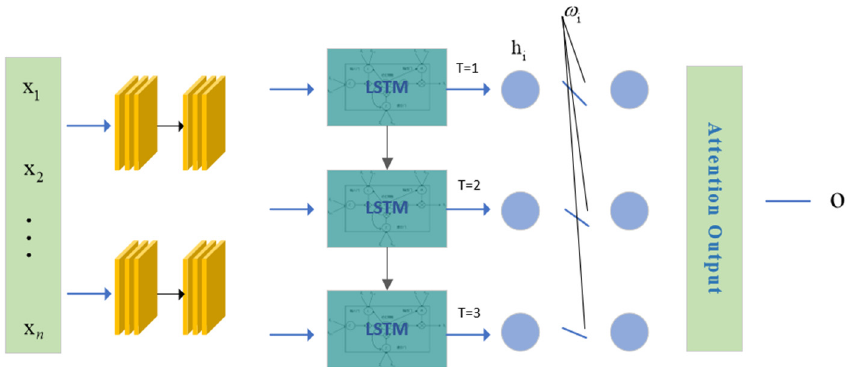
Figure 5. Prediction framework diagram.